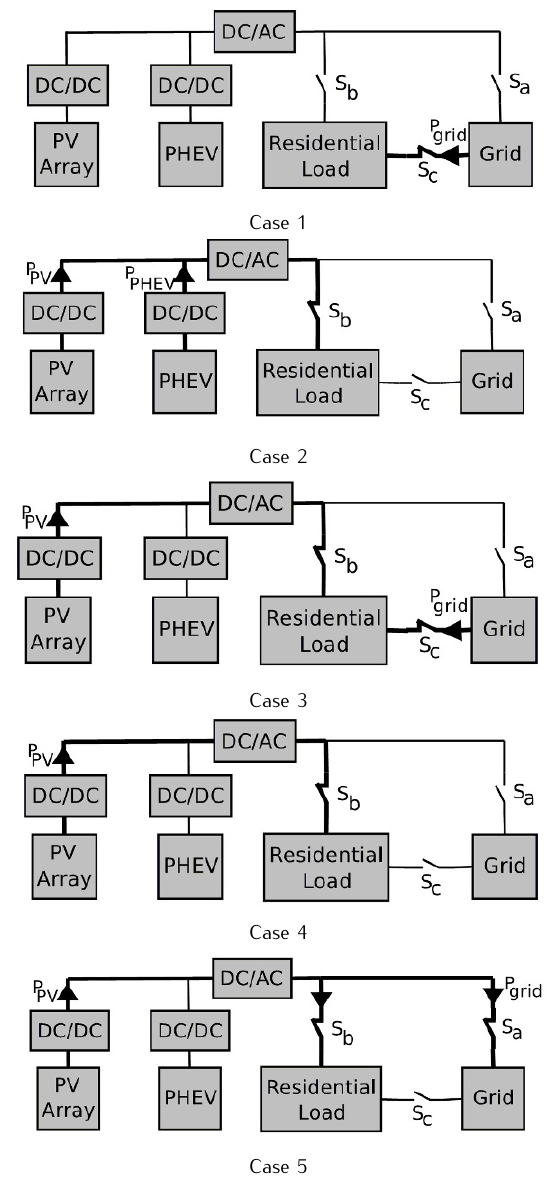
Figure 5. Five operation modes of the proposed system